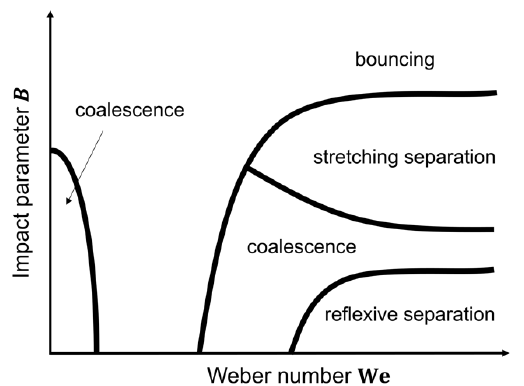
Figure 7. Collision map (modified from Li et al. [163]).